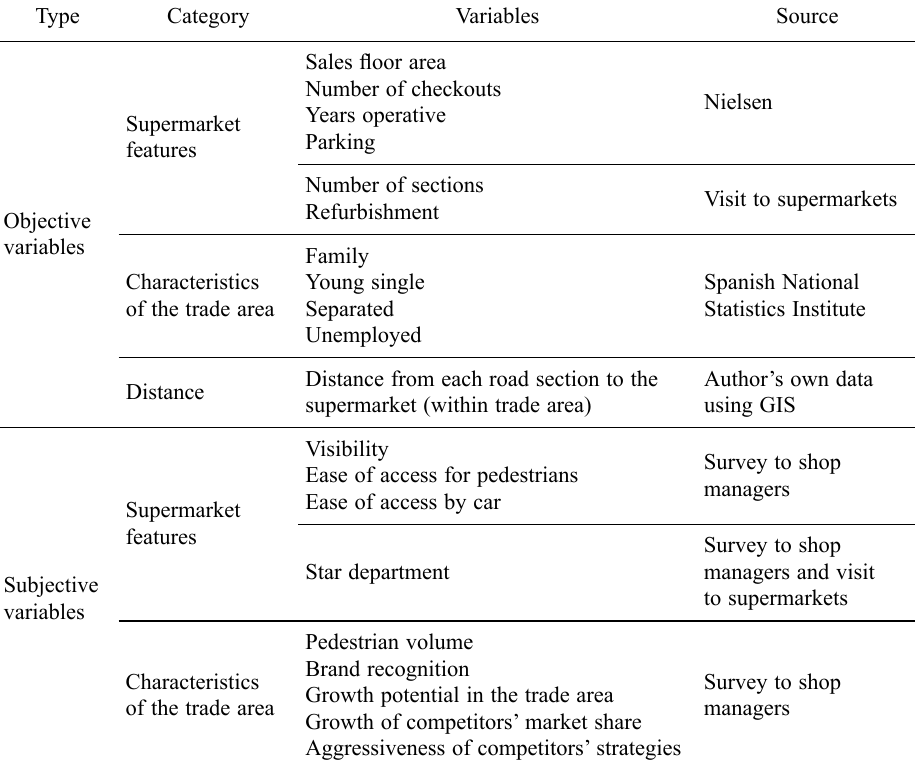
Table 1. Independent variables and data